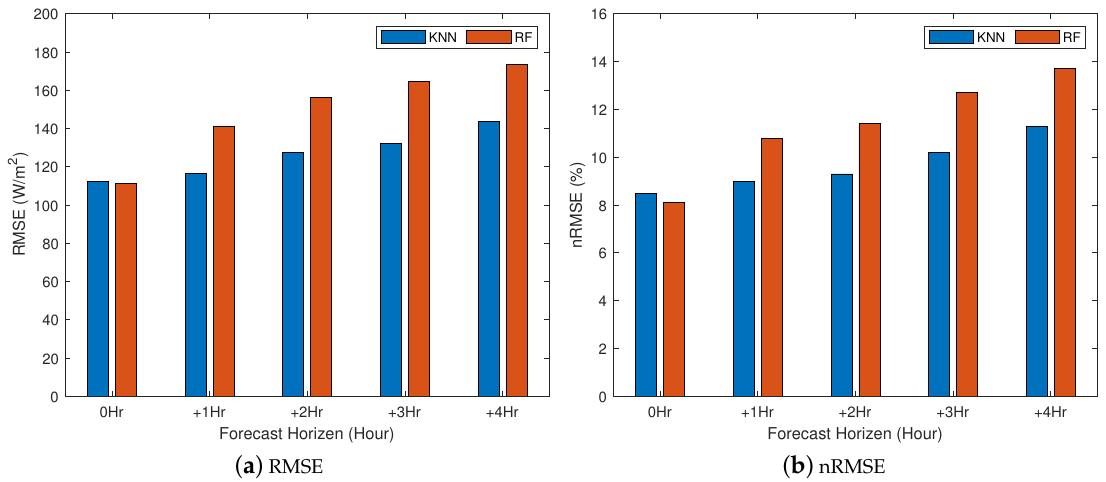
Figure 6. RMSE and nRMSE prediction errors for K-nearest neighbors (KNN) and Random Forest (RF). Three types of weather conditions are considered to compare the predicted solar irradiance of the